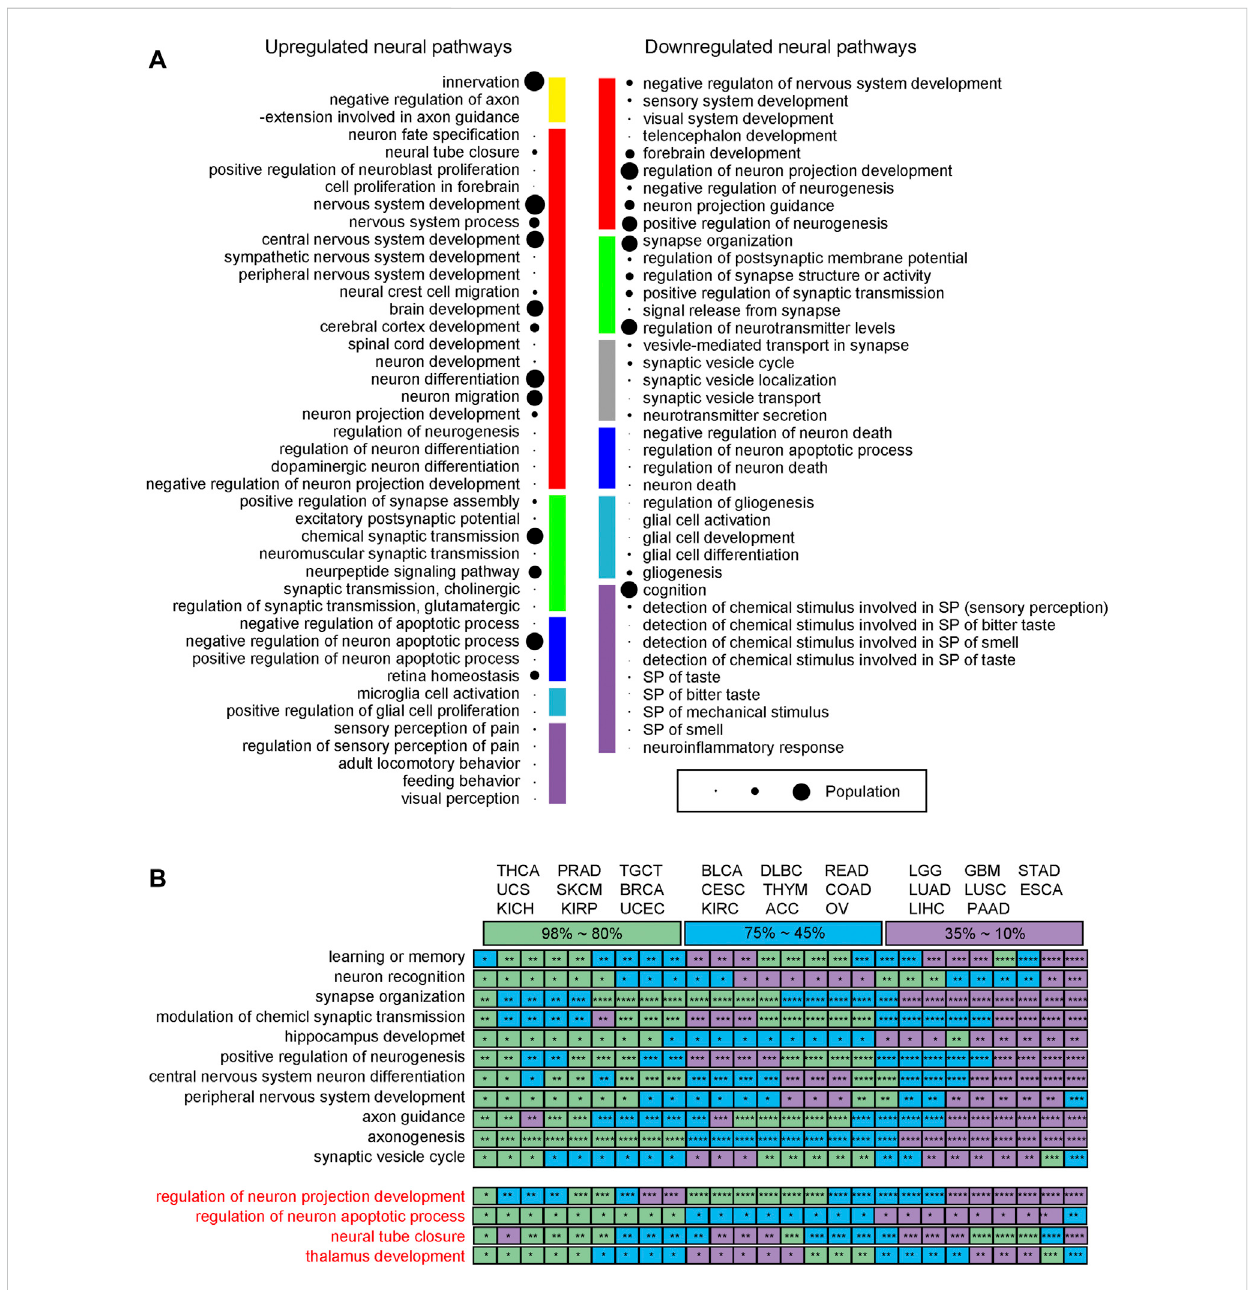
Neuralfunctions across26cancertypes. (A) Functionsofupregulatedanddownregulatedneuralgenes.Thesizeofabubblerepresentsthenumber of pathways covered, ranging from 1 to 26. Yellow is for axon guidance related pathways. Red is for neuron differentiation related pathways. Green is for synapse organization related pathways. Blue is for neuron apoptosis related pathways. Sky blue is for glia cell activation related pathways. Purple is for neuronal perception related pathway; and grey denotes neurotransmitter transport related pathways. (B) The mean fi ve-year survival rates for different cancer types according to the SEER reports, where the rates are color coded with purple for 10% – 35% covering ESCA, GBM, LGG, LIHC, LUAD, LUSC, PAAD, and STAD, blue for 45% – 75% covering ACC, BLCA, CESC, COAD, DLBC, KIRC, OV, READ, and THYM, and green for 80% – 98% covering BRCA, KICH, KIRP, PRAD, SKCM, TGCT, THCA, UCEC, and UCS, respectively. * is for a p -value between 1.0E-10 and 0.05; ** for a p -value between 1.0E- 010 and 1.0E-20; *** for a p -value between 1.0E-20 and 1.0E-30; and **** for a p -value <